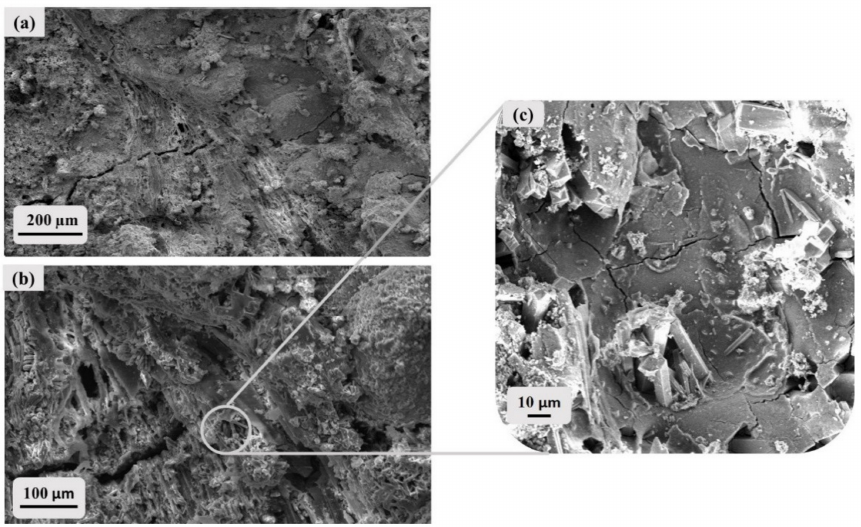
Figure 7. SEM images of NYT and CI at different magnifications after brushing treatment with LS solution (dilution 1:1): ( a ) CI (100X), ( b ) NYT (400X), ( c ) NYT